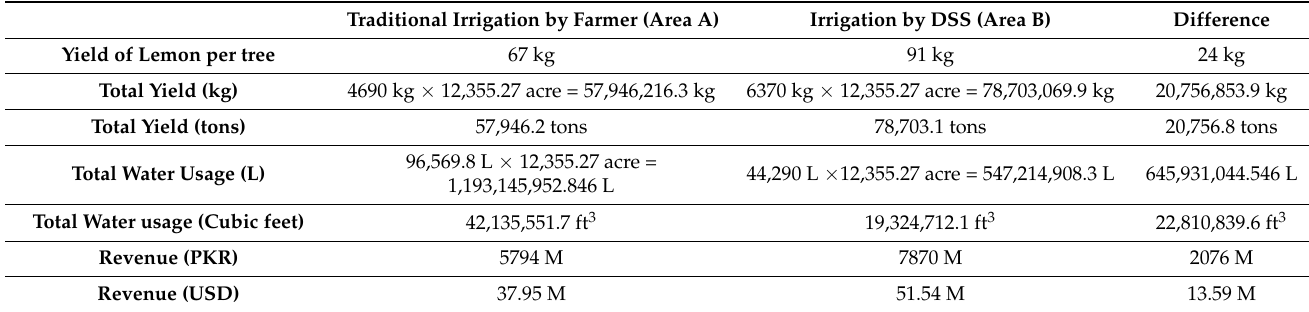
Table 4. Yield increase for annual cultivation of lemon crop in